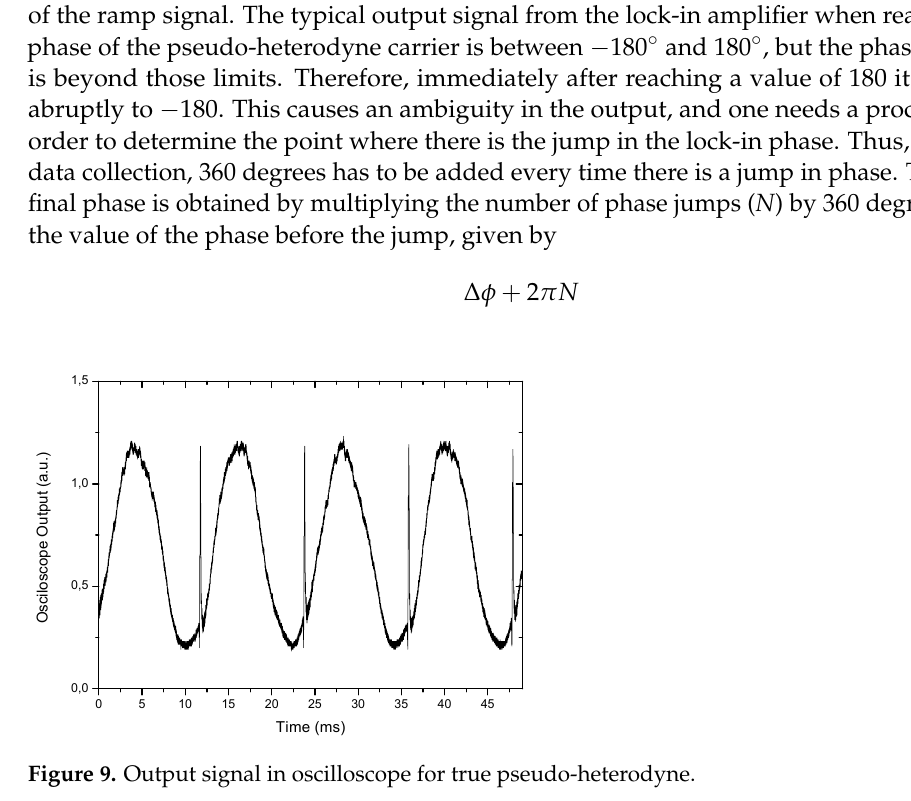
Figure 9. Output signal in oscilloscope for true pseudo-heterodyne.